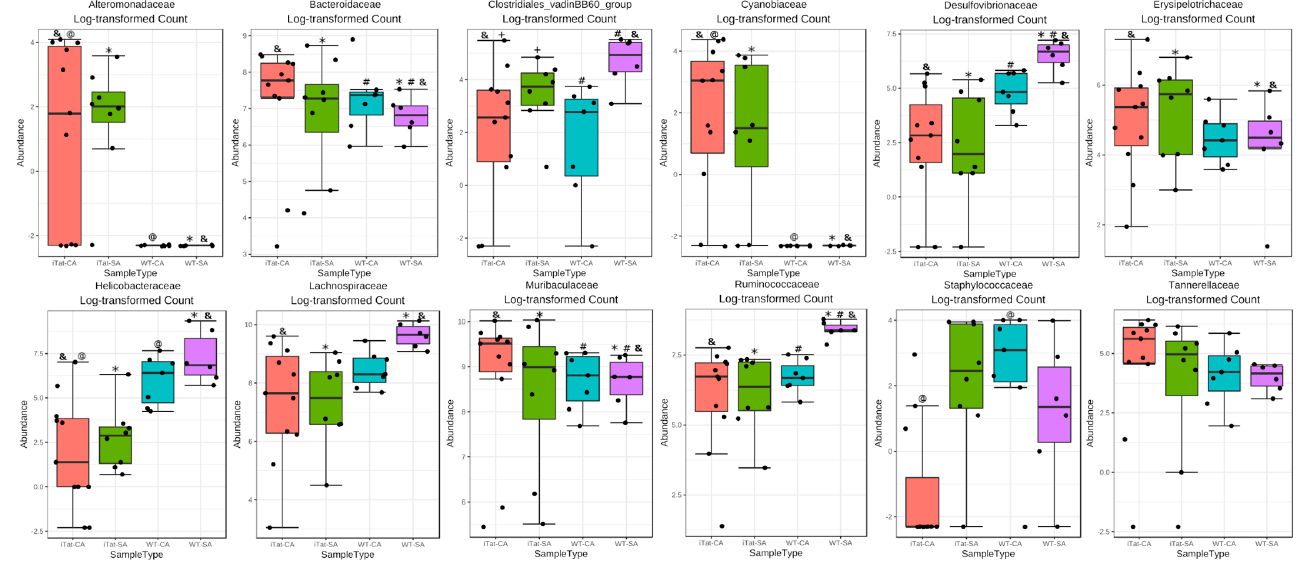
Figure 6. Effects of Tat expression and cocaine exposure on microbial abundance by family in the gut of 12-month female mice. Twelve families which were affected in either group were presented. The data were analyzed using Kruskal–Wallis test, followed by post hoc Games–Howell’s test. The families which were affected by Tat expression and/or cocaine exposure were marked in red. The error bars were SD, and “*”, “#”, “&”, “@” or “+” denoted p < 0.05.